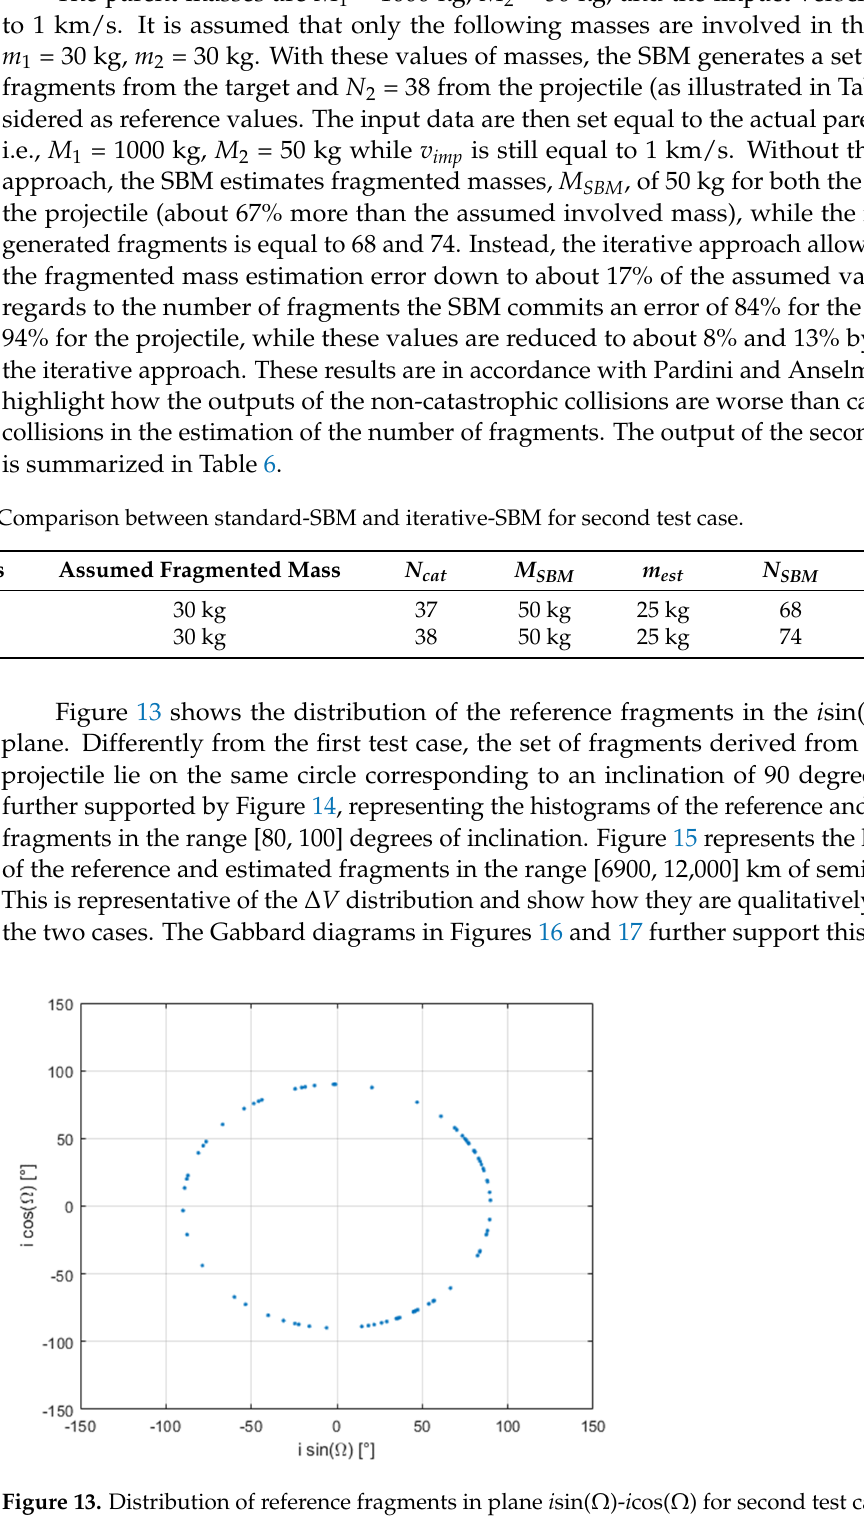
( a ) ( b ) Figure 14. Histograms of reference ( a ) and estimated ( b ) fragments in range [80°, 100°] of inclination for second test case.